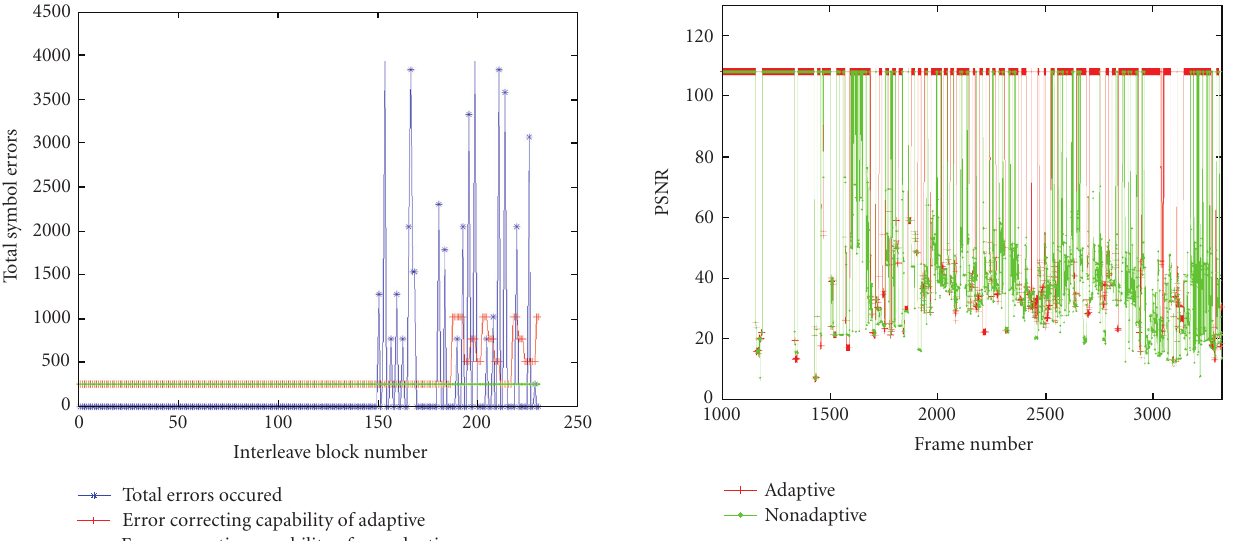
Figure 9: PSNR comparisons for “ all” sequence at 32kbps, random